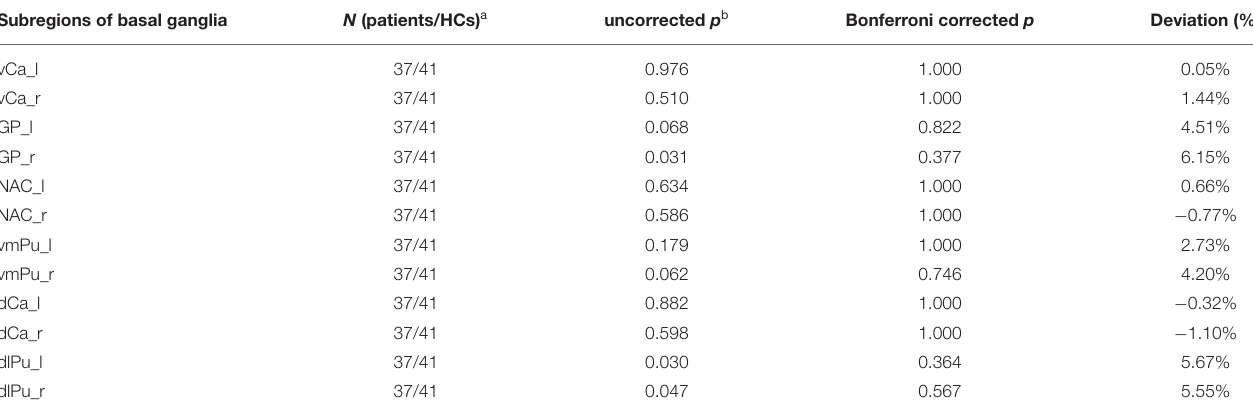
TABLE 3 | Changes in sub-regional volume of basal ganglia in OCD patients derived from Atlas-based analysis using SPM. Subregions of basal ganglia N (patients/HCs) a uncorrected p b Bonferroni corrected p